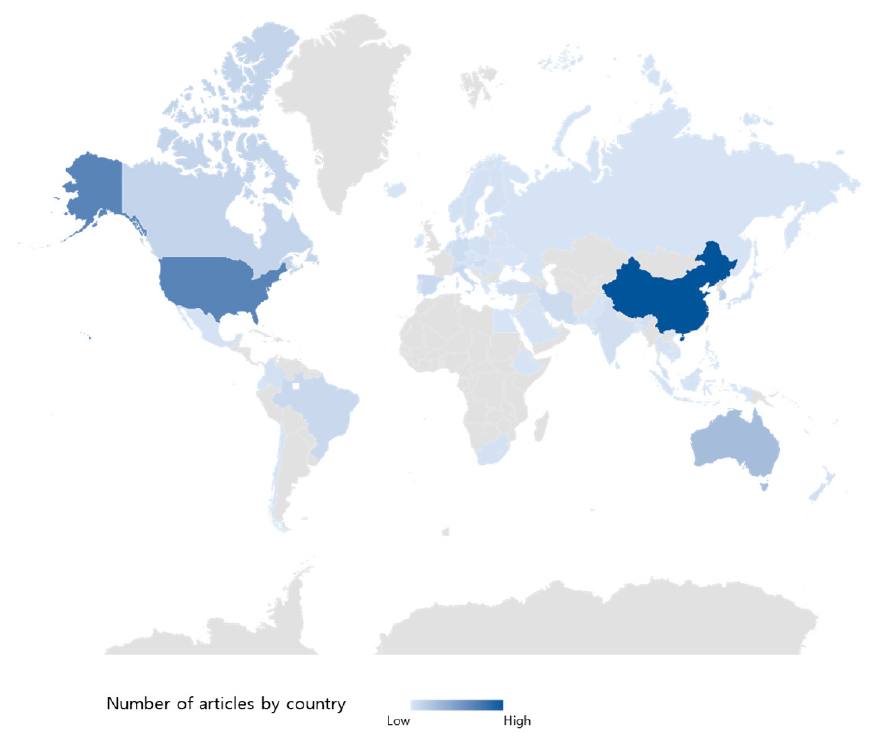
Figure 4. Global geographical distribution of authors’ locations.